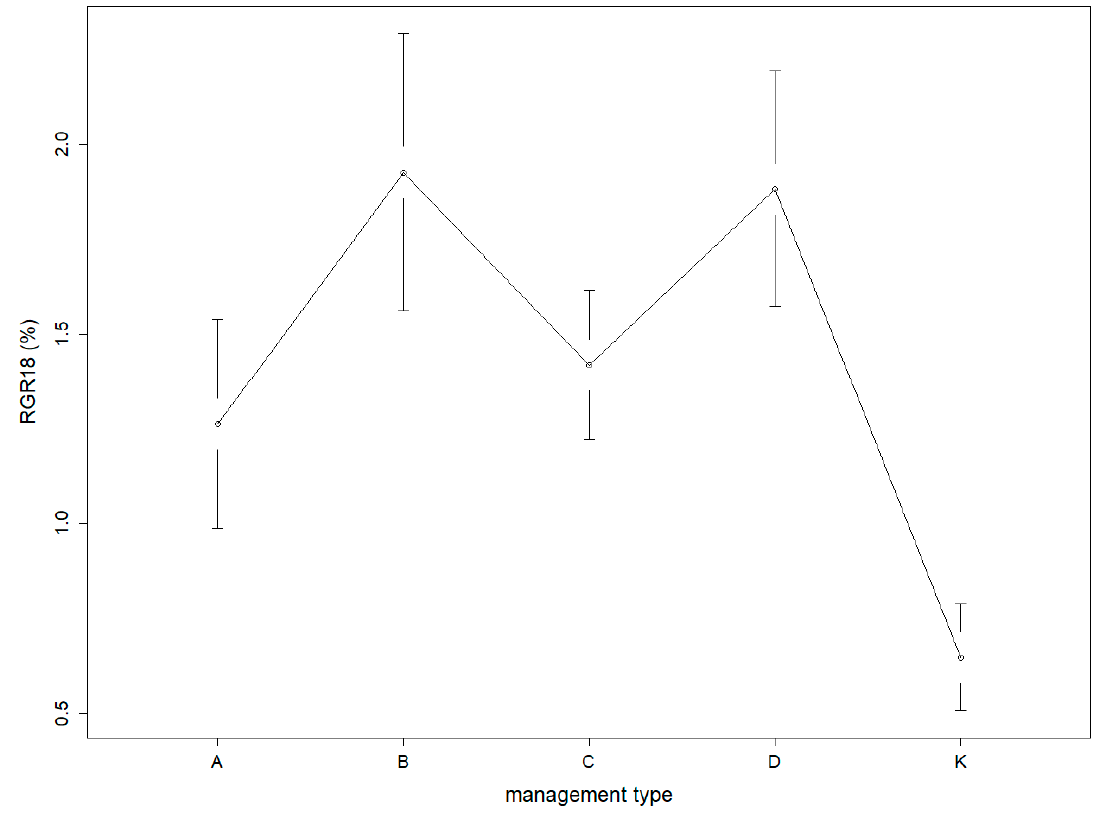
Figure 5. Mean values (with 95% confidence intervals) of the RGR of the circumference of the oak standards according to the applied management type in 2018 (A: coppice-with-standards + raking + grazing; B: coppice-with-standards + grazing; C: coppice-with-standards + raking; and D: coppice-with-standards, K–control, RGR 18 (%) is the circumference RGR of oak standards in 2018).